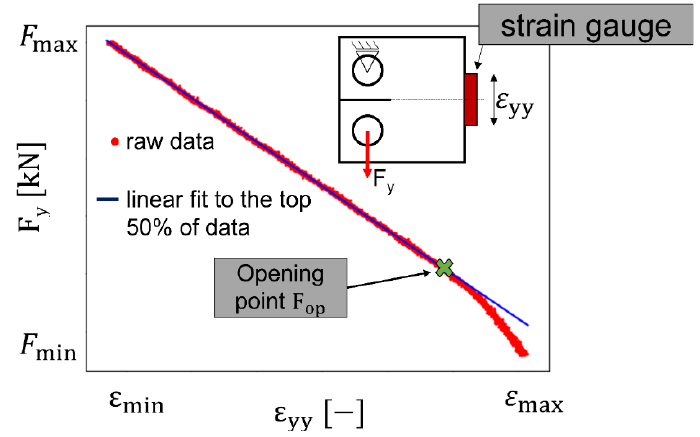
Figure 1. Exemplary F y vs. ε yy curve ( ε yy is measured by a strain gauge at the specimen’s backside). The linear interpolation (blue) shows the material response for a fully open crack.